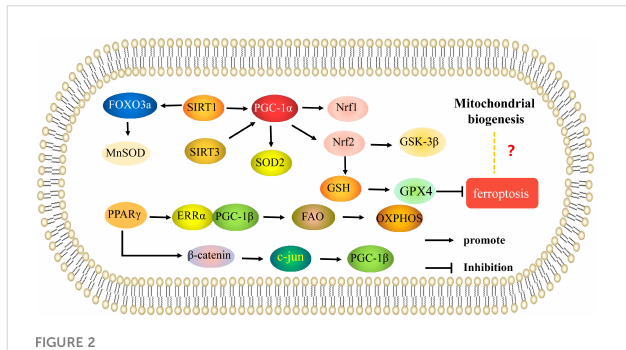
FIGURE 2 Mitochondrial biogenesis is involved in the mechanisms of regulation of osteoporosis. Mechanisms of mitochondrial biogenesis that regulate osteoblasts and osteoclasts in osteoporosis. The arrows indicate activation and the inhibitory arrows indicate